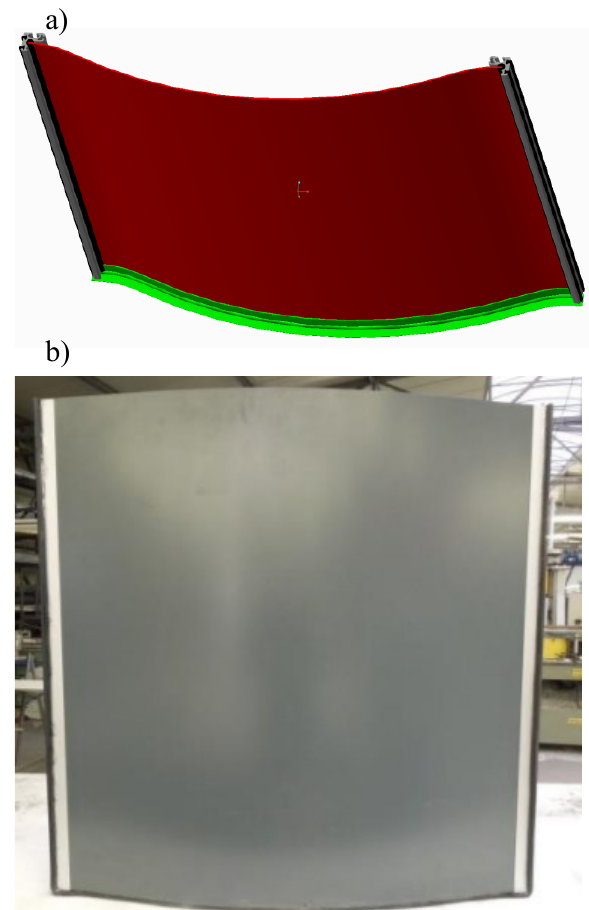
Fig. 2 . Development of the prototype of mobile anti-flood board: a) CAD model, b) real